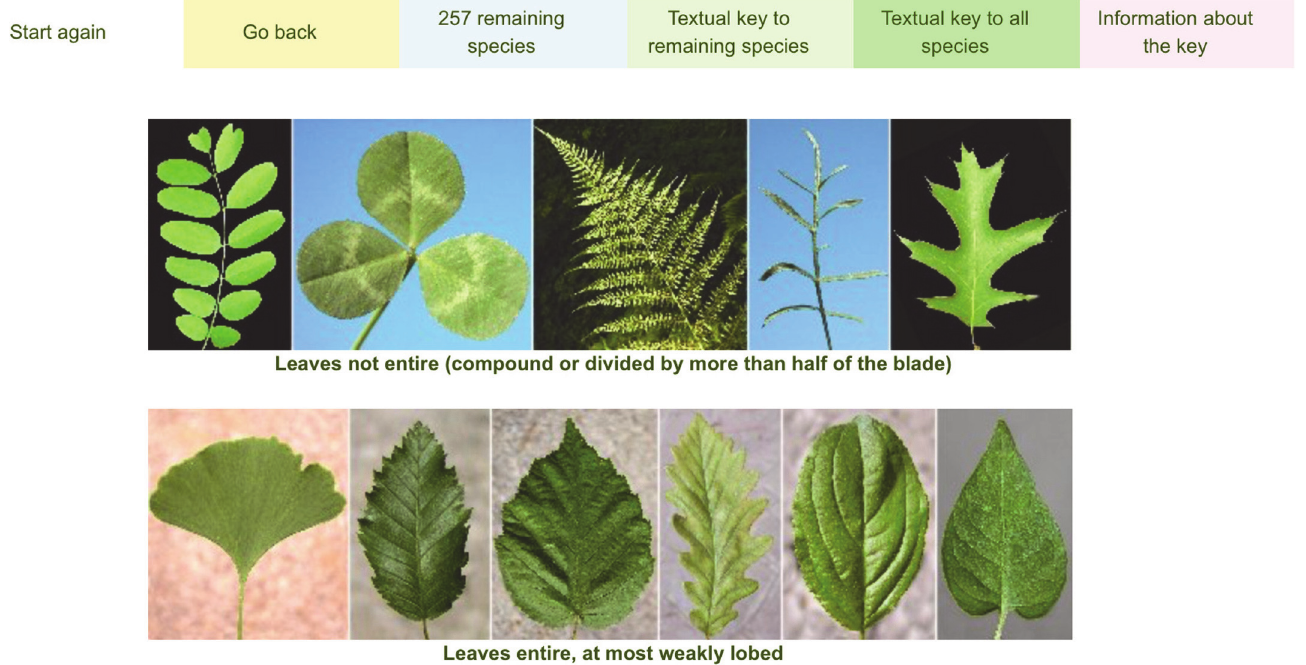
Fig 8. Digital dichotomous key. It includes only the taxa selected using the multi-entry